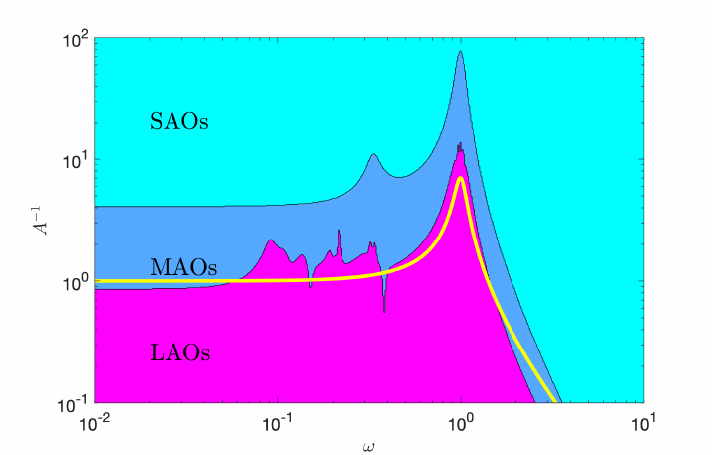
Figure 7. Approximated regions of the pendulum’s oscillation modes as a function of frequency and amplitude ( η =